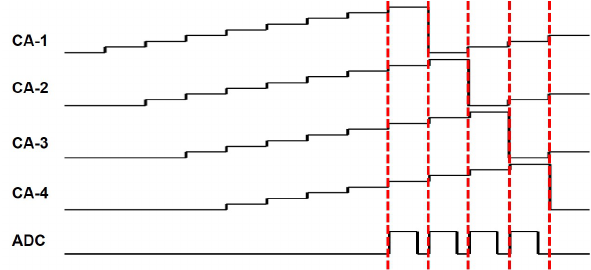
Figure 9. The SNR improvement is achieved by accumulating output pulses of charge amplifiers. CA-1 to CA-4 are the accumulated voltages for the outputs of four charge amplifiers. The outputs accumulated over several pulses are sampled by the ADC.